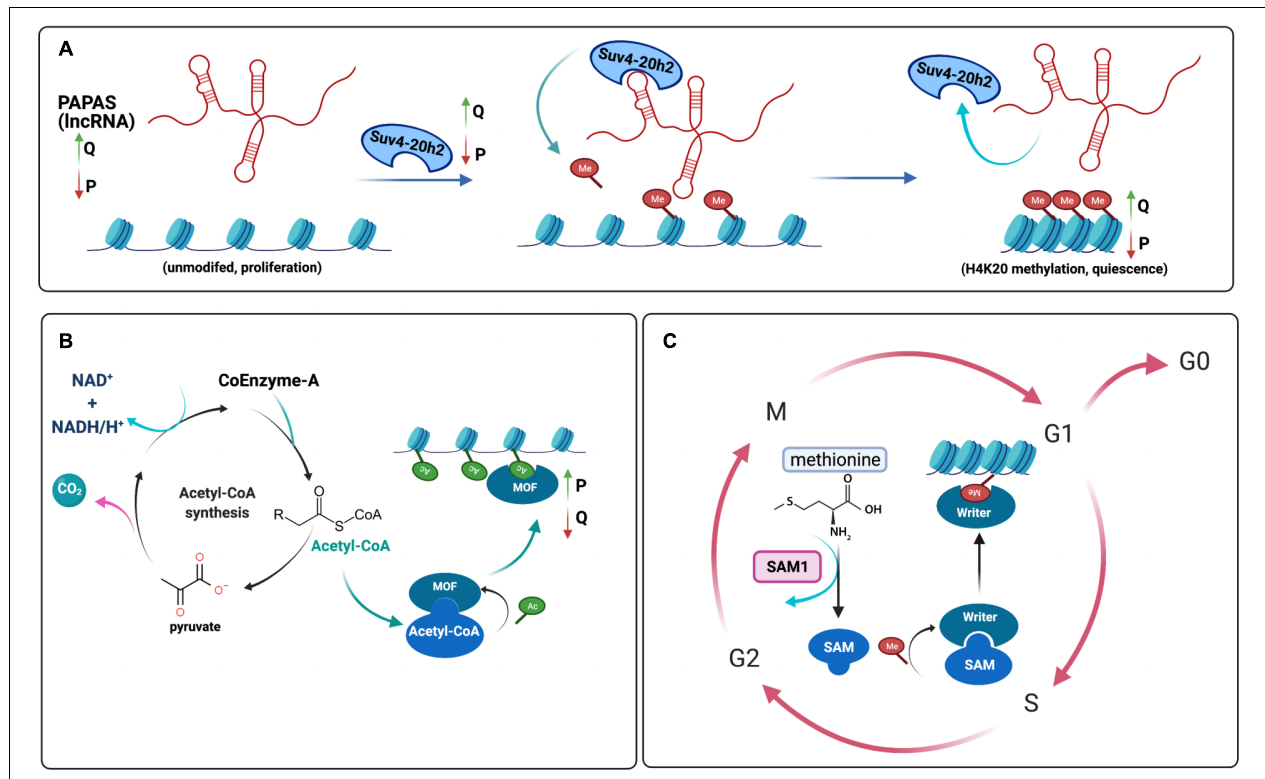
FIGURE 3 | Histone Modifications and Metabolism | (A) During quiescence, the writer Suv420h2 adds methyl groups to H4K20 via mediation with the lncRNA PAPAS. PAPAS, Suv4-20h2, and H4K20 methylation levels all increase with quiescence (Q) compared to proliferation (P), as indicated by the arrows (Bierhoff et al., 2014). (B) Acetyl-CoA acts as an acetyl group donor for histone acetyltransferases, including MOF, which is responsible for H4K16 acetylation during proliferation (Khoa et al., 2020). (C) In fission yeast, synthesis of S-adenosylmethionine (SAM) from methionine with the help of S-Adenosylmethionine synthetase (Sam1) is implicated in histone methylation. SAM acts as a methyl donor for methyltransferases; thus, Sam1 is necessary for proper cell growth and proliferation, as well as quiescence maintenance (Hayashi et al., 2018) (Figure made in